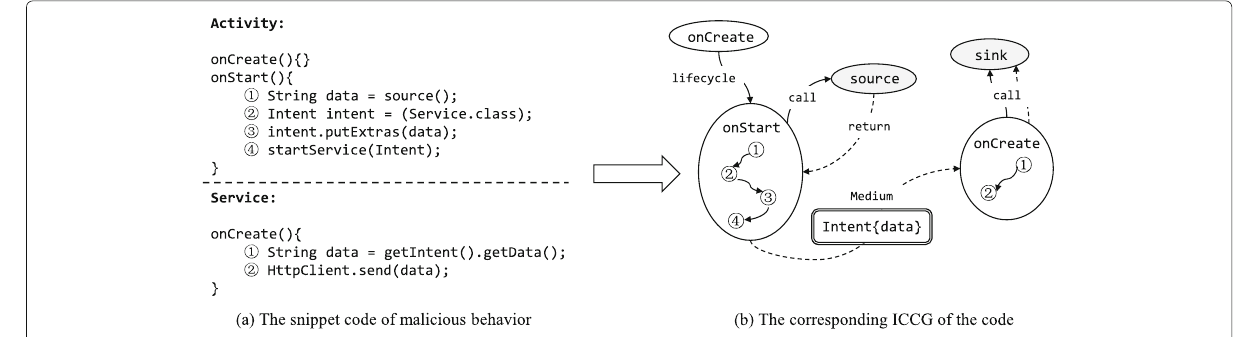
Fig. 1 An example of malicious behaviors and the corresponding ICCG. a The snippet code of malicious behavior b The corresponding ICCG of the